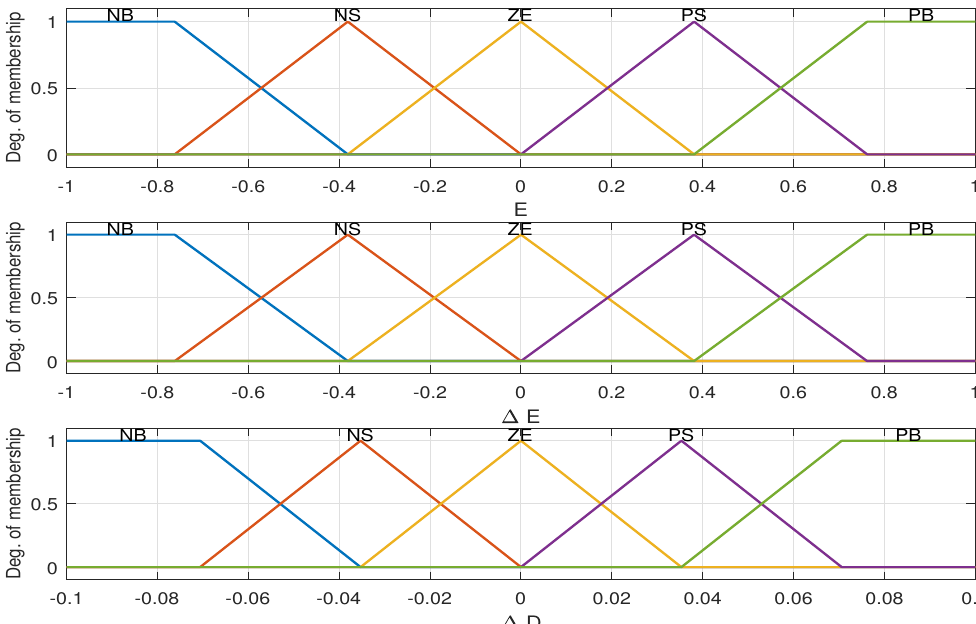
Figure 4. The membership functions of the fuzzy logic control (FLC) inputs ( E and ∆ E ) and out- put ( ∆ D